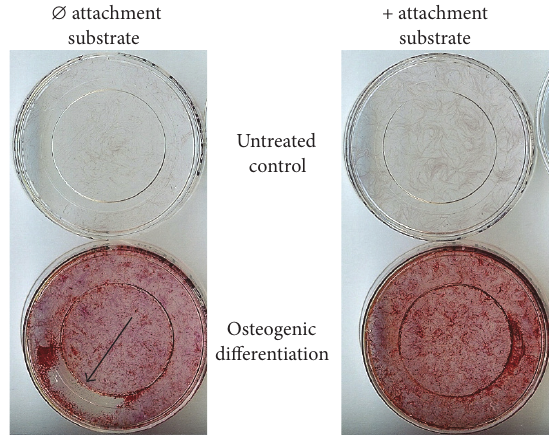
Figure 1: MSCA-1 + JPCs were seeded into uncoated/coated glass bottom dishes under untreated and osteogenic conditions. Plates without attachment were unproblematic for untreated JPCs. On the basis of increased detachment of osteogenically induced monolayers, glass bottom dishes coated with MesenCult-XF attachment substrate were used for all Raman